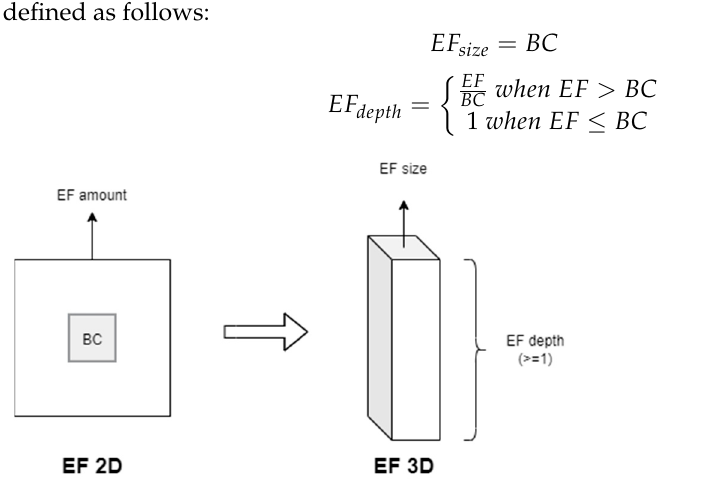
Figure 2. From 2D EF to 3D EF.